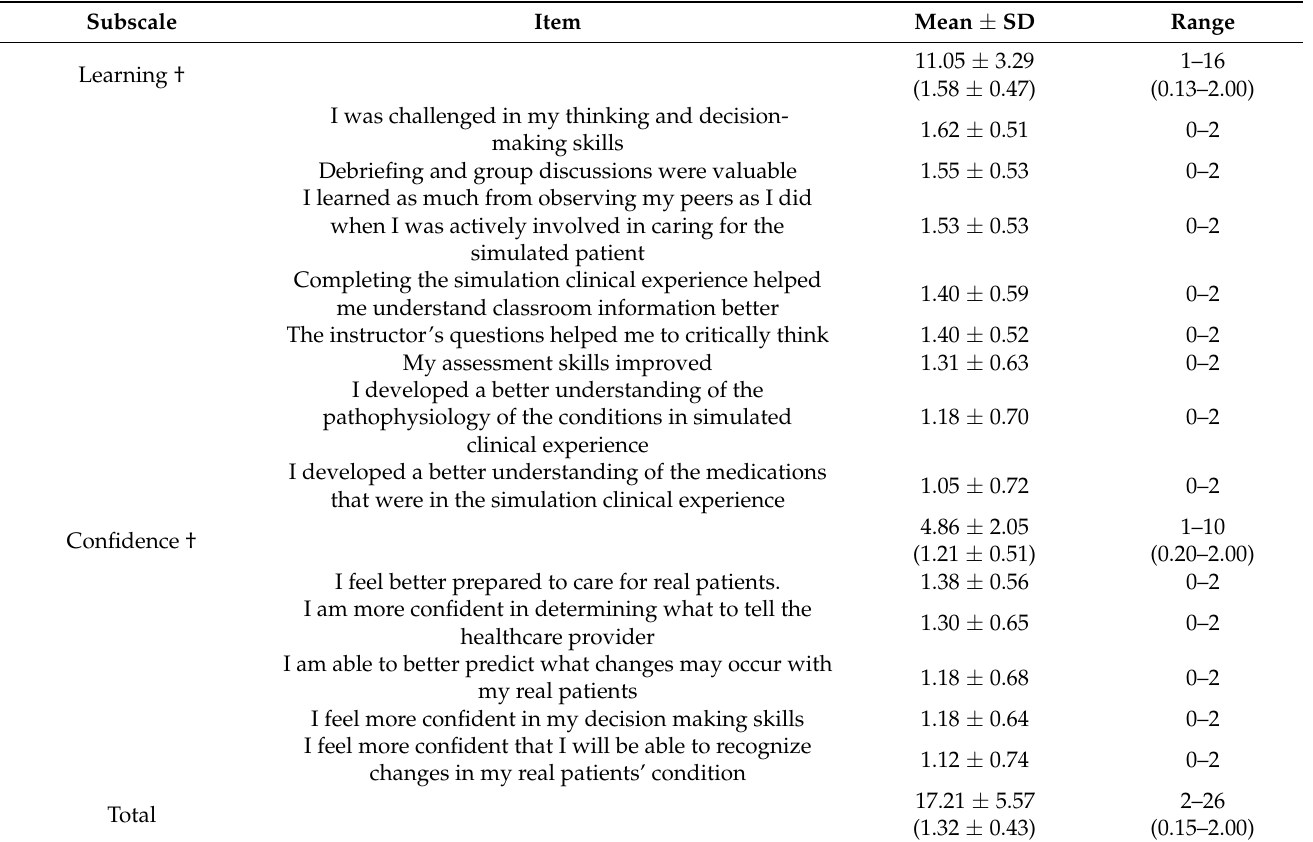
Table 3. Rank order of simulation effectiveness tool score ( n =